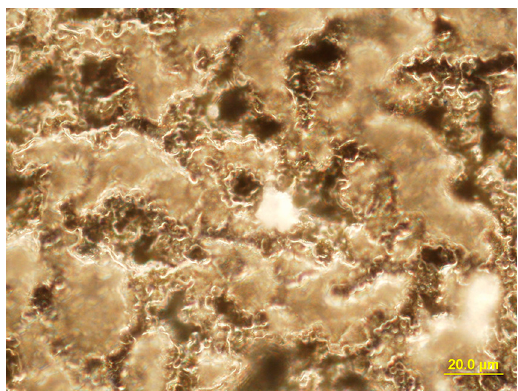
Figure 5. Location of Jurkat T cells on the rough surface of the TiO 2 coating. Reflecting optical microscopy, dark field. Magnification, 1000 × .